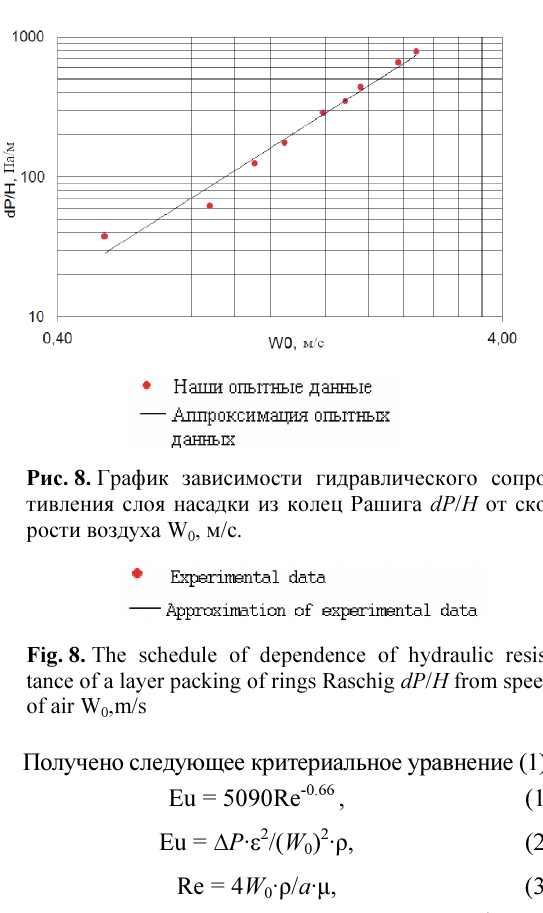
Fig. 7. The schedule of dependence of hydraulic resis- tance of a layer packing of N3C dP / H from speed of air W 0 , m/s